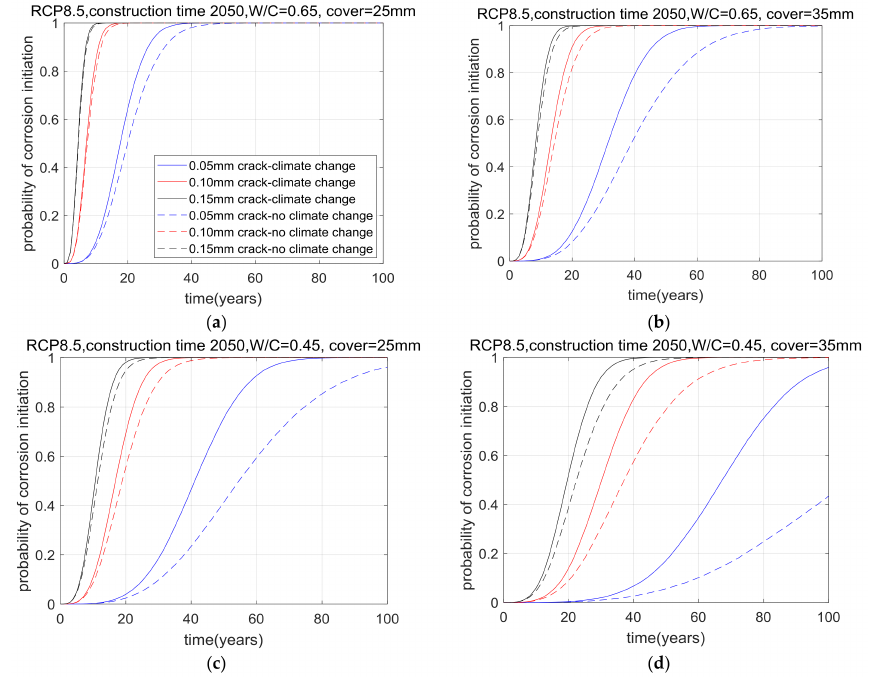
Figure 12. Probability of corrosion initiation-RCP 8.5, time slice 2050. ( a ) W/C: 0.65, Cover depth: 25 mm; ( b ) W/C: 0.65, Cover depth: 35 mm; ( c ) W/C: 0.45, Cover depth: 25 mm; ( d ) W/C: 0.45, Cover depth: 35 mm.